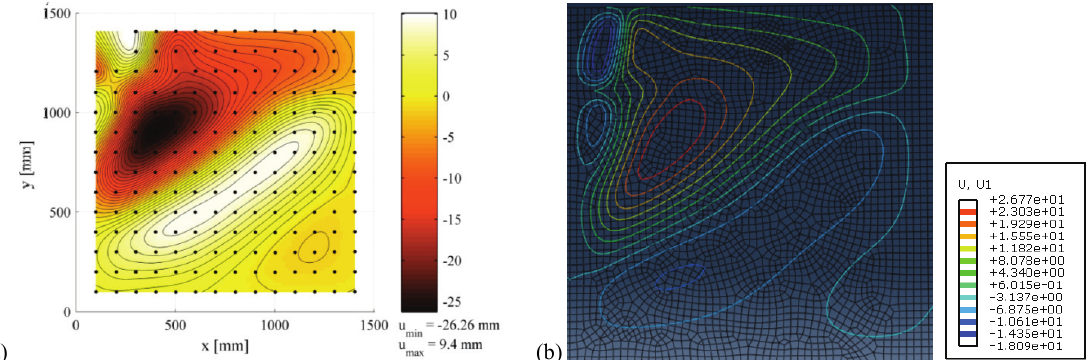
Fig. 10. Displacements [mm] perpendicular to central plane of web in panel S0 (test S0) at maximum vertical displacement U2 = 55